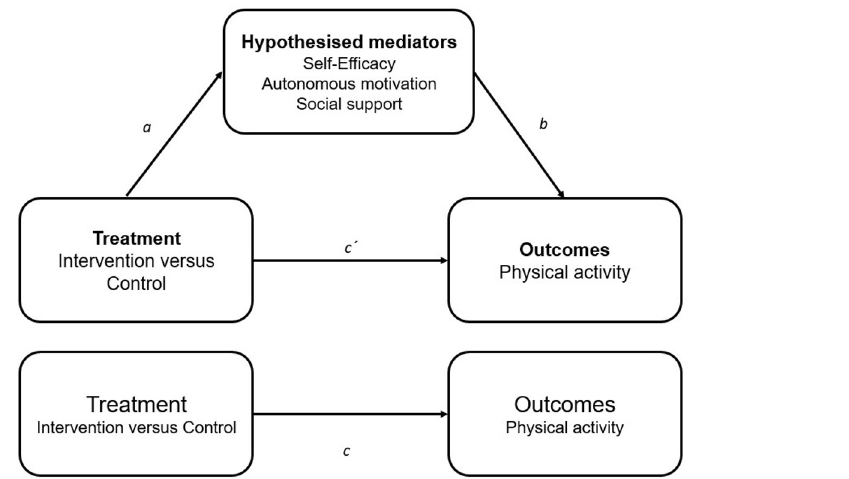
Fig 2. Hypothesized mediators of physical activity behavior